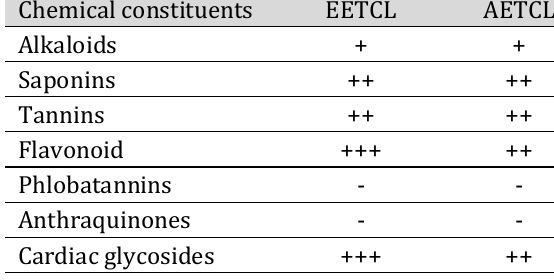
Table 1. Qualitative phytochemistry of ethanolic and aqueous extracts of Terminalia catappa leaf.